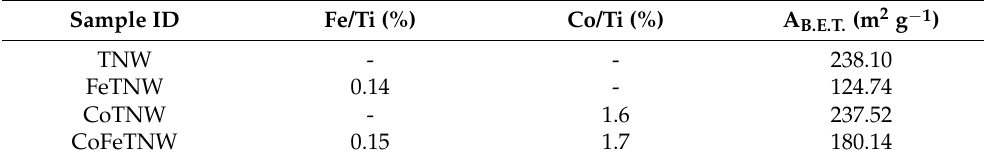
Table 1. Relative atomic percentage of iron and cobalt incorporated in TNW, CoTNW, FeTNW and CoFeTNW samples and correspondent specific surface